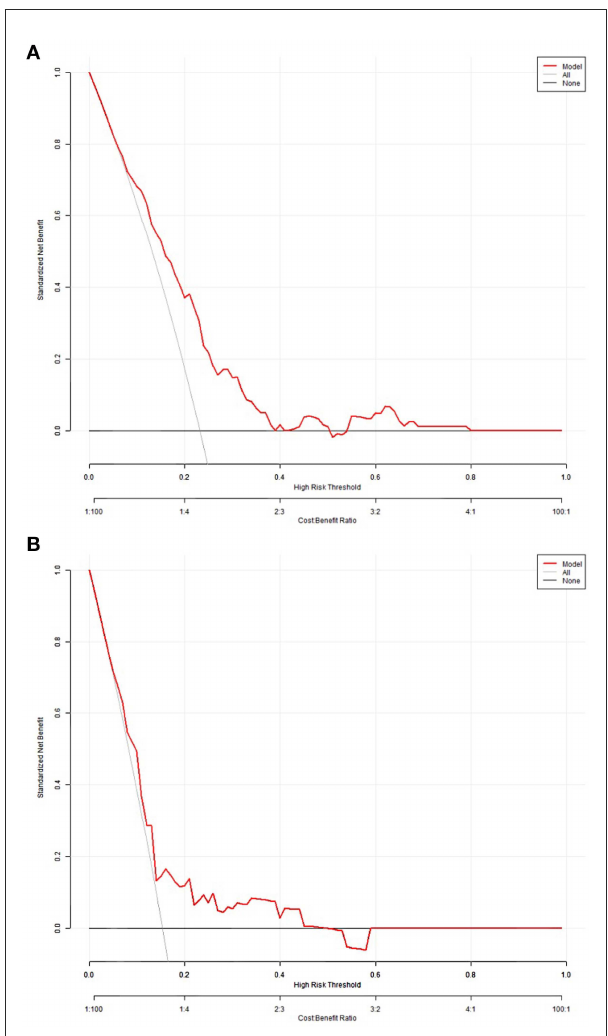
FIGURE4 Decision curves for in-hospital death probability in the derivation (A) and validation cohorts (B)